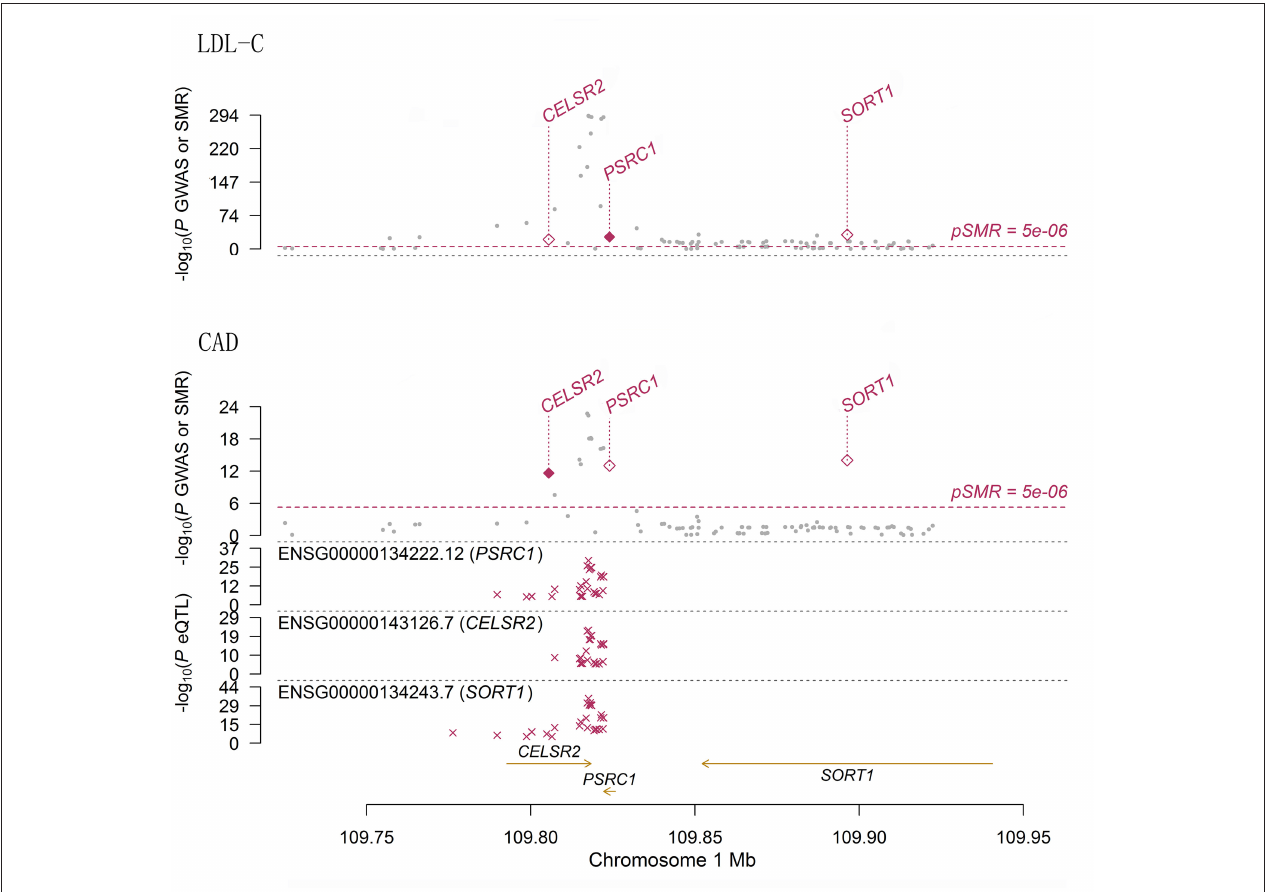
FIGURE 2 | The association between mRNA expression levels of 1p13.3 genes and LDL-C and CAD in liver cells. The two panels present the results of the associations between mRNA expression levels of 1p13.3 genes and LDL-C and CAD in liver. Each panel consists of two parts. The x-axis represents the genomic position (GRCh37.p13). The lower part of each panel shows the results of eQTL. The y-axis represents –log 10 ( P eQTL). In this part we can see that SNPs in 1p13.3 were strongly associated with the mRNA expression levels of SORT1 , PSRC1 , or CELSR2 . The upper part of each panel shows the results of GWAS (gray dots) and SMR (red rhombus) analysis. The y-axis represents –log 10 ( P GWAS or SMR). In this part we can see that SNPs in 1p13.3 were strongly associated with LDL-C and CAD. According to the SMR analysis, the mRNA expression levels of SORT1 , PSRC1 , and CELSR2 in liver cells were significantly associated with LDL-C and CAD.